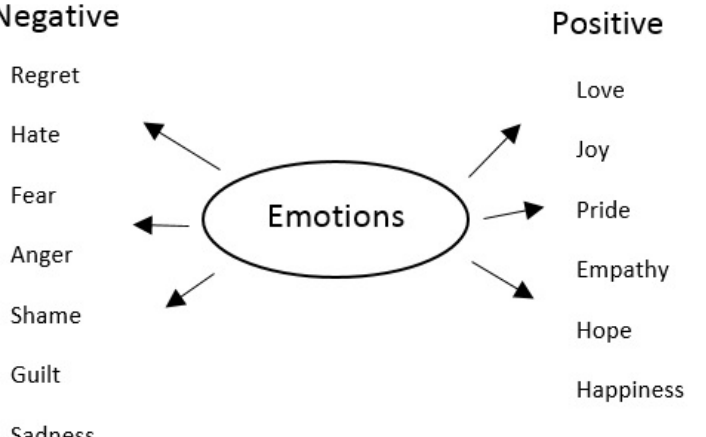
Figure 2. Positive and negative emotions.